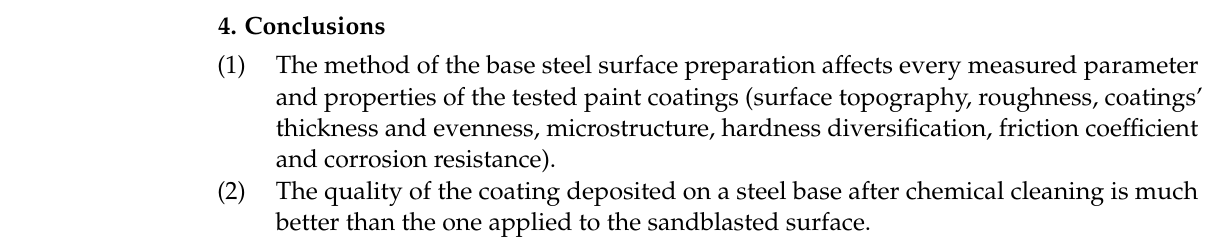
was stopped and the parts were checked macroscopically. It should be noted that on the